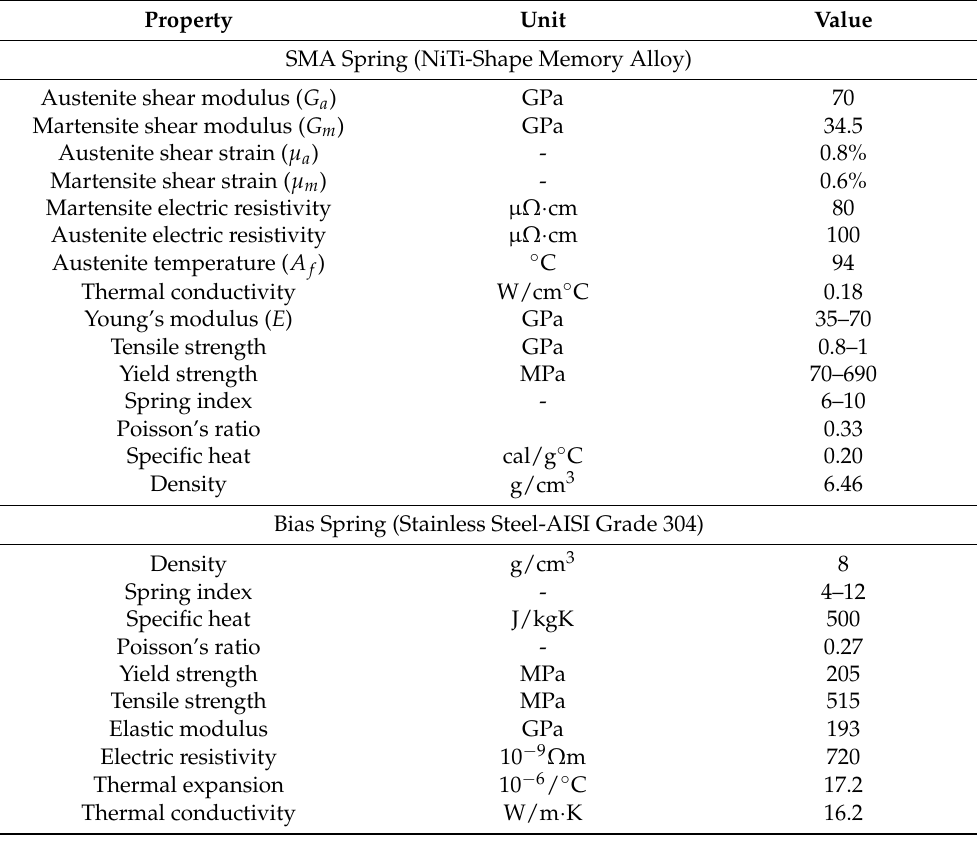
Table 3. Material properties of SMA and bias springs.